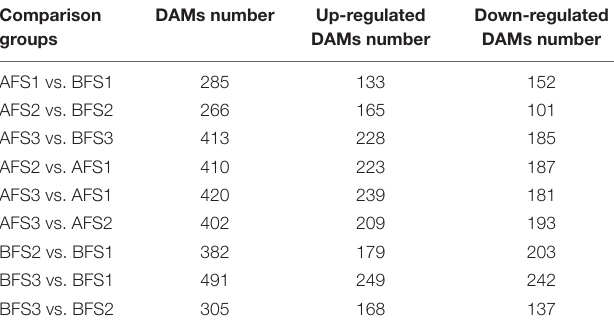
TABLE 1 | Comparison of differential accumulated metabolites in the fruits of two oriental melon cultivars A and B. Comparison DAMs number groups